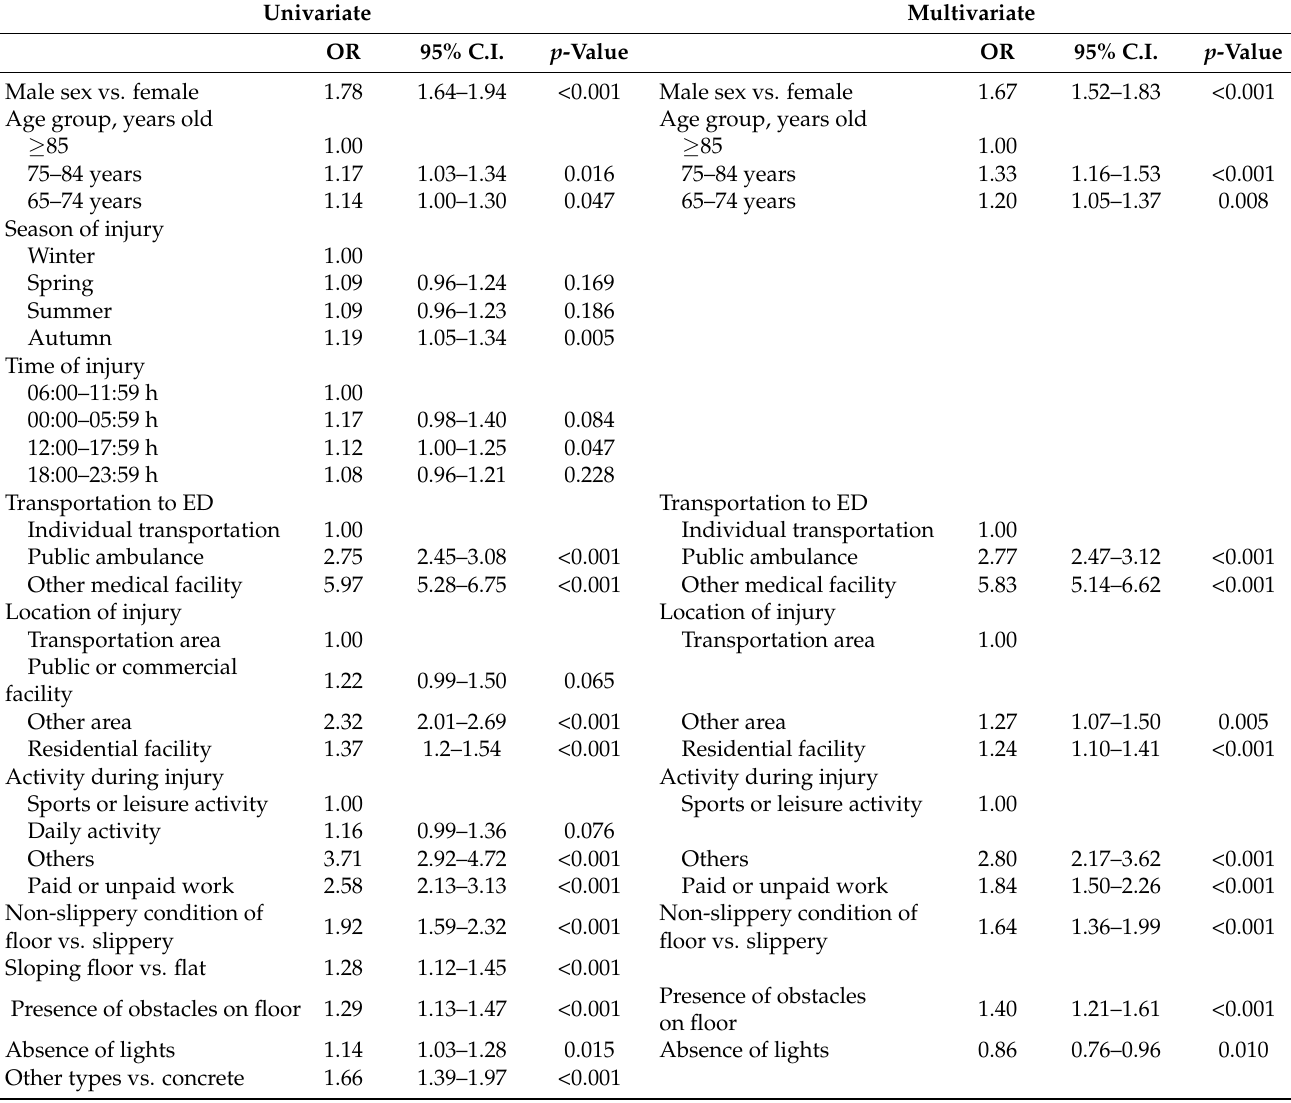
Table 5. Factors associated with severe injury after ground fall in non-alcoholic elderly